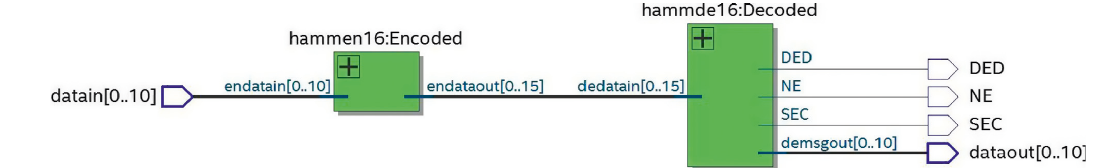
Figure 10: I/O overview of VHDL code for Hamming [16, 11, 4]